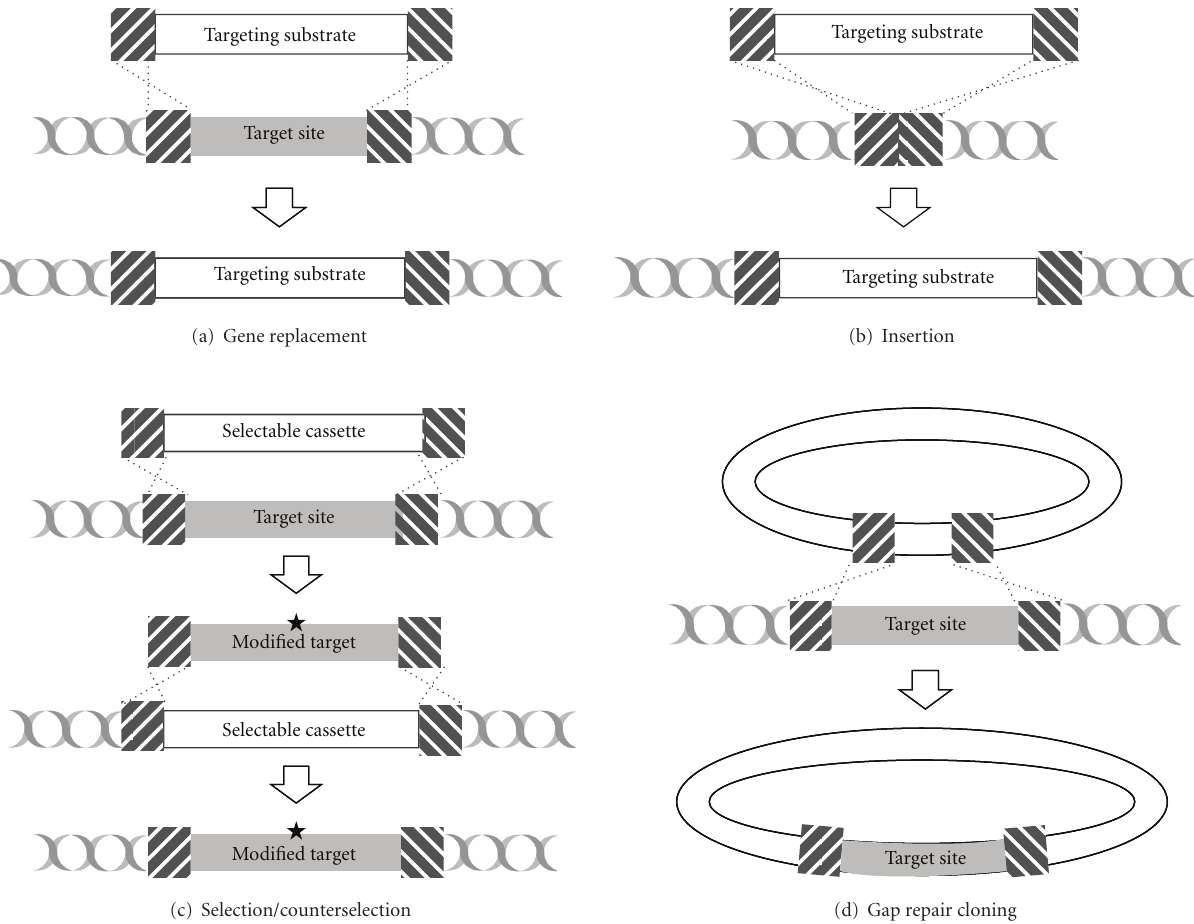
Figure 1: General applications of recombineering in BAC modifications. Recombineering is applicable in various mutagenesis strategies, depending on the design and nature of the targeting substrate and target site; see text for more details. Stippled boxes denote homologous sequences for recombination. (a) Gene replacement. Recombineering can be employed to replace a target site with any sequence of interest. (b) Insertion. DNA can also be introduced by recombineering without removing any of the existing sequence. (c) Selection/counterselection. Recombineering can mediate subtle modifications such as nucleotide substitutions via two rounds of recombinations, by first introducing a selectable cassette followed by replacement of the cassette with the modified version of the target site. (d) Gap repair cloning. A target site of interest can be cloned from a fragment or plasmid into a linearised vector in vivo by recombineering, through recombination between the ends of the cloning vector and target